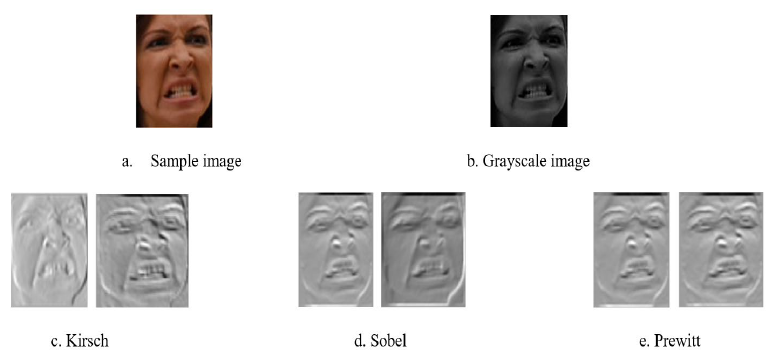
Figure 4. Edge detection obtained using various operators.